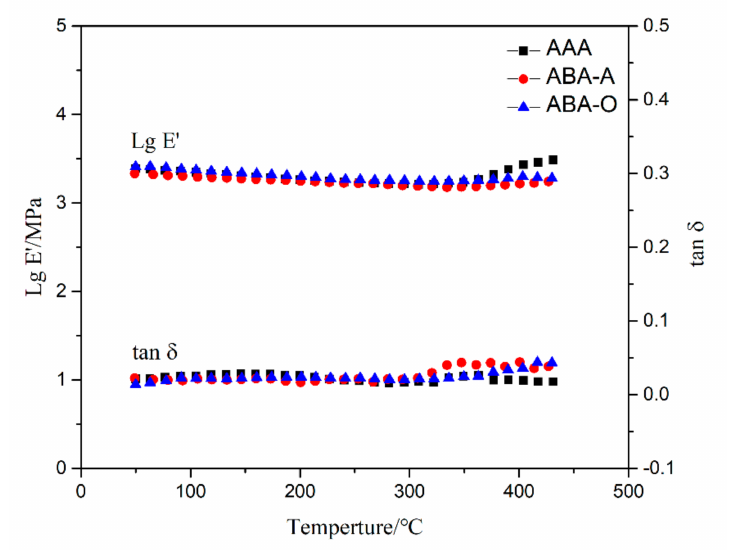
Figure 8. DMA curves of cured